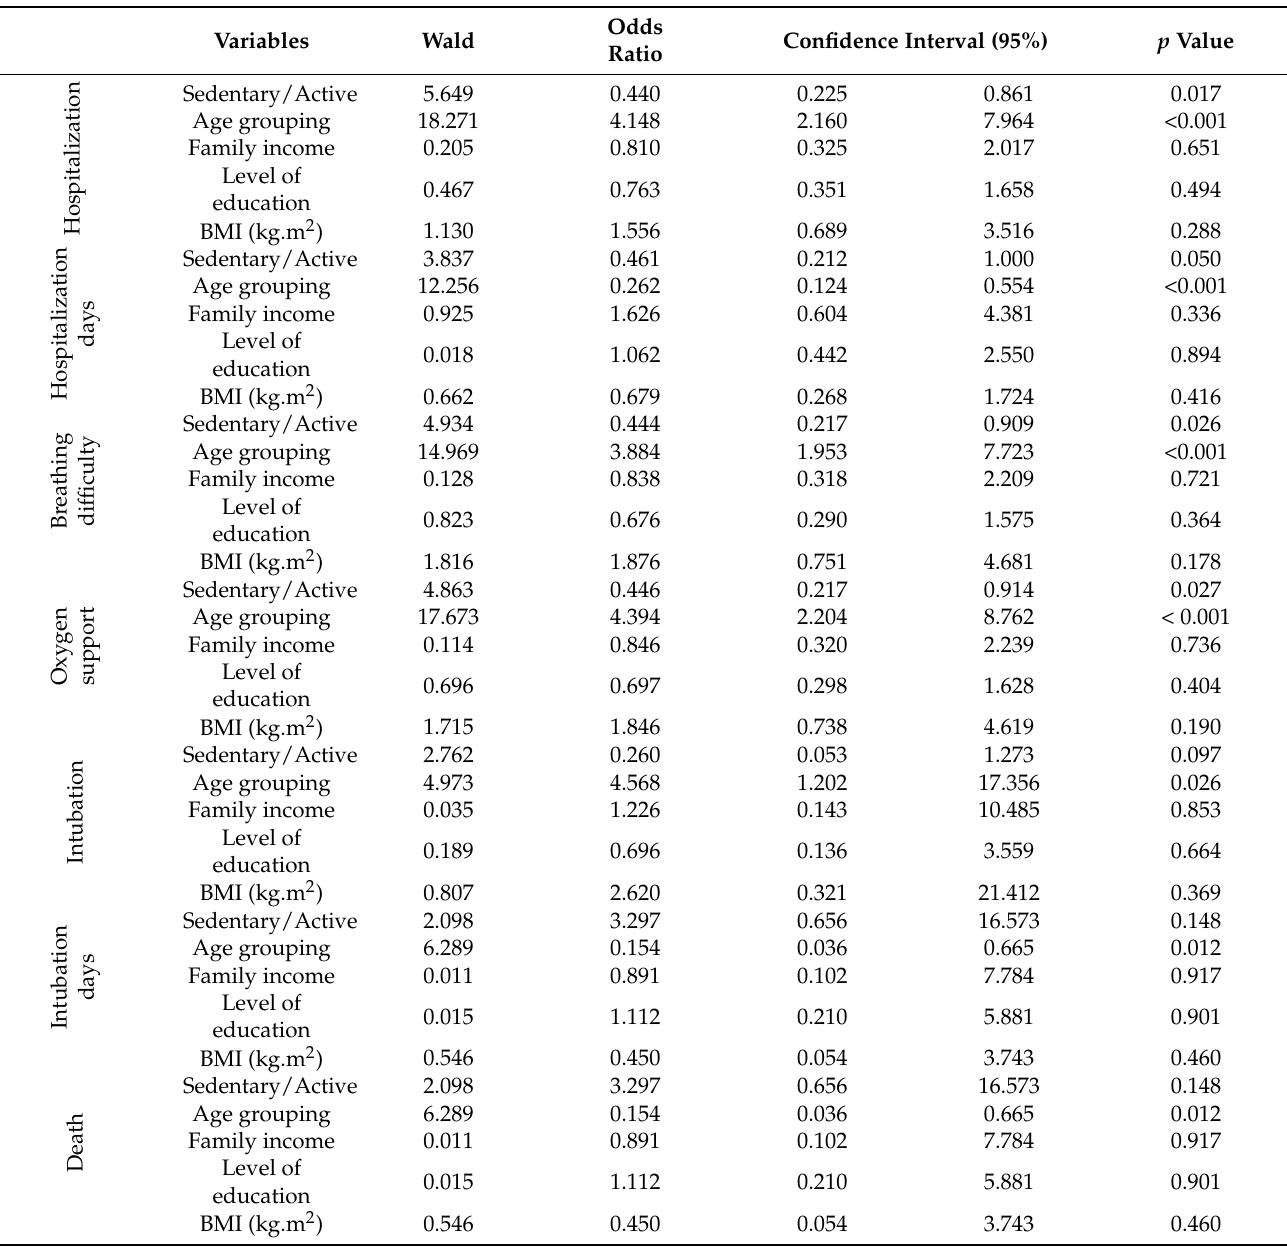
Table 2. Odds ratio between sedentary and active groups for the occurrence of clinical outcomes of COVID-19. Ribeir ã o Preto, Brazil,